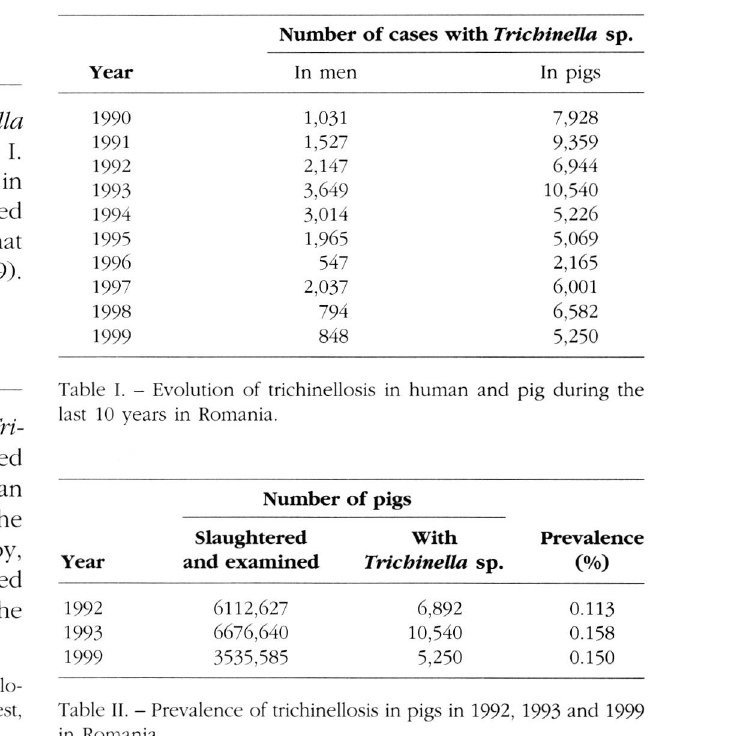
Table II. - Prevalence of trichinellosis in pigs in 1992, 1993 and 1999 in Romania.